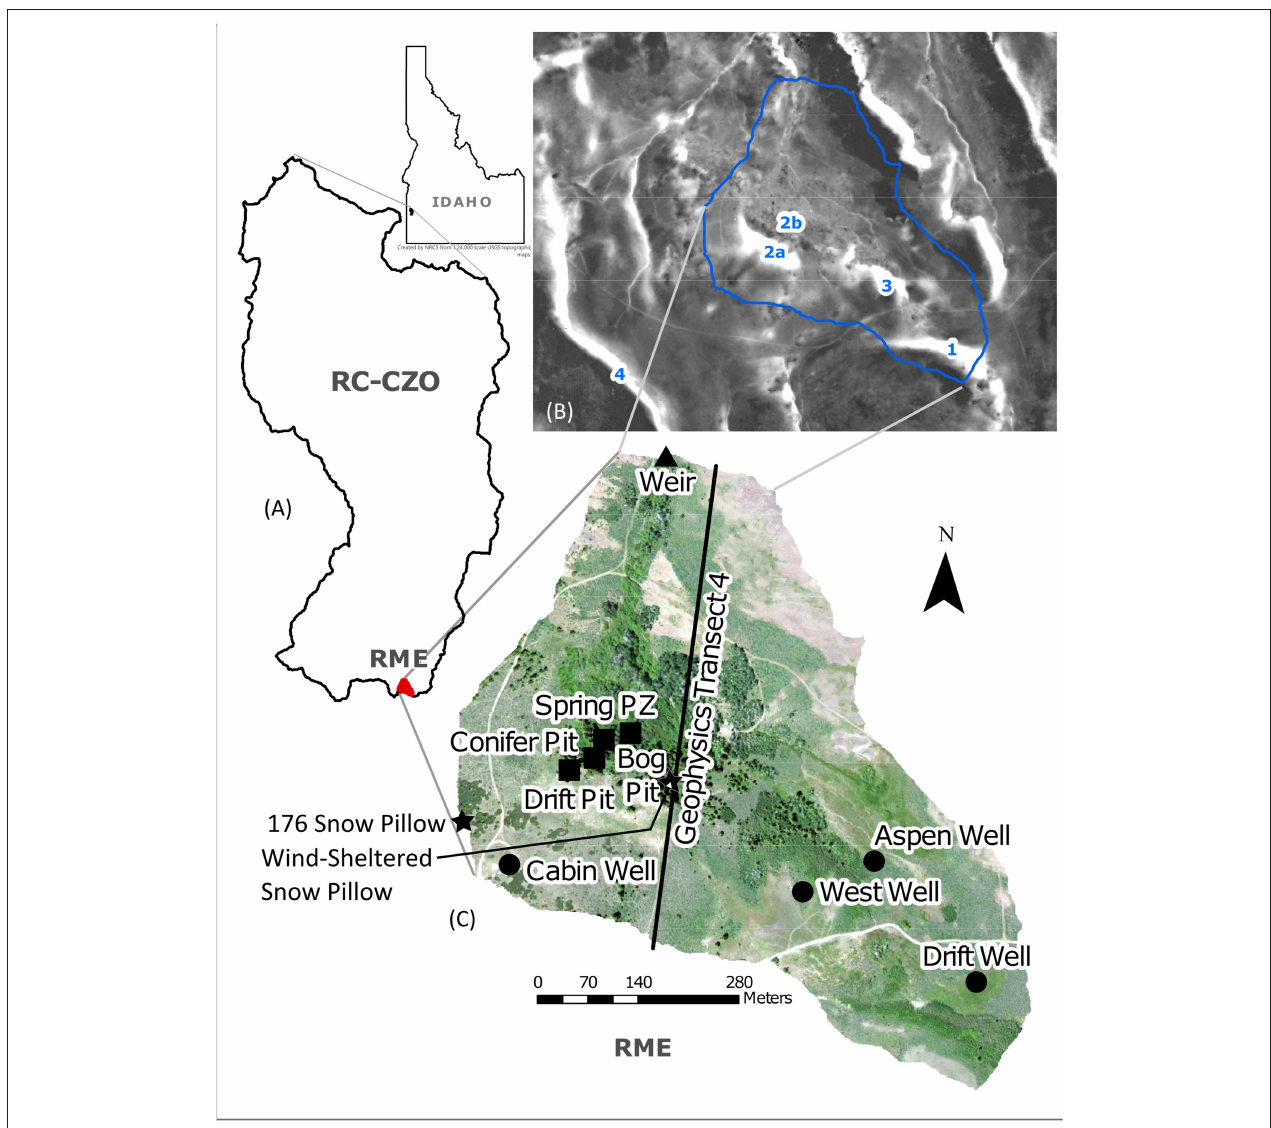
FIGURE 1 | (A) The Reynolds Mountain East (RME) catchment is located in southwestern Idaho, USA, at the southern end of the Reynolds Creek CZO. (B) Snowdrifts in RME are highlighted by a snow depth map from March 2009 (an average snow year) with white areas indicating drifts marked by numbers 1, 2a&b, 3, and 4 referenced in the main text. Snow depth data from Shrestha (2016). (C) Annotated RME orthophoto outlines instrument and sampling locations. 176 is the “exposed ridge” meteorology station and Judd snow-depth site; the “wind-sheltered” snow pillow is directly in line with the geophysics transect. “PZ” stands for piezometer, which is co-located with the soil moisture and matric-potential probes at each pit.